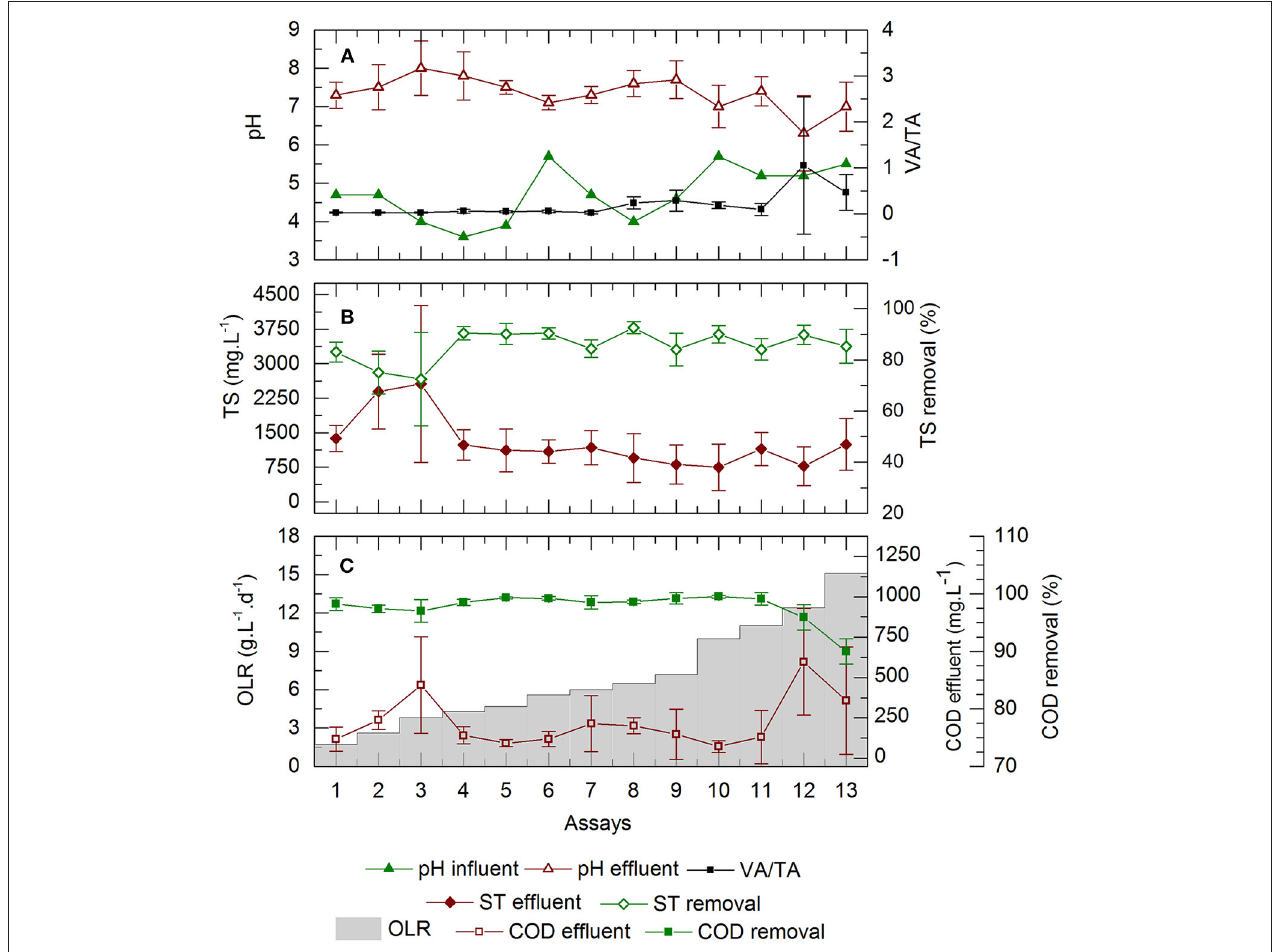
FIGURE 2 | R2 performance: (A) pH in the effluent and VA/TA ratio; (B) total solids in the effluent and total solids removal efficiency; (C) COD in effluent and COD removal